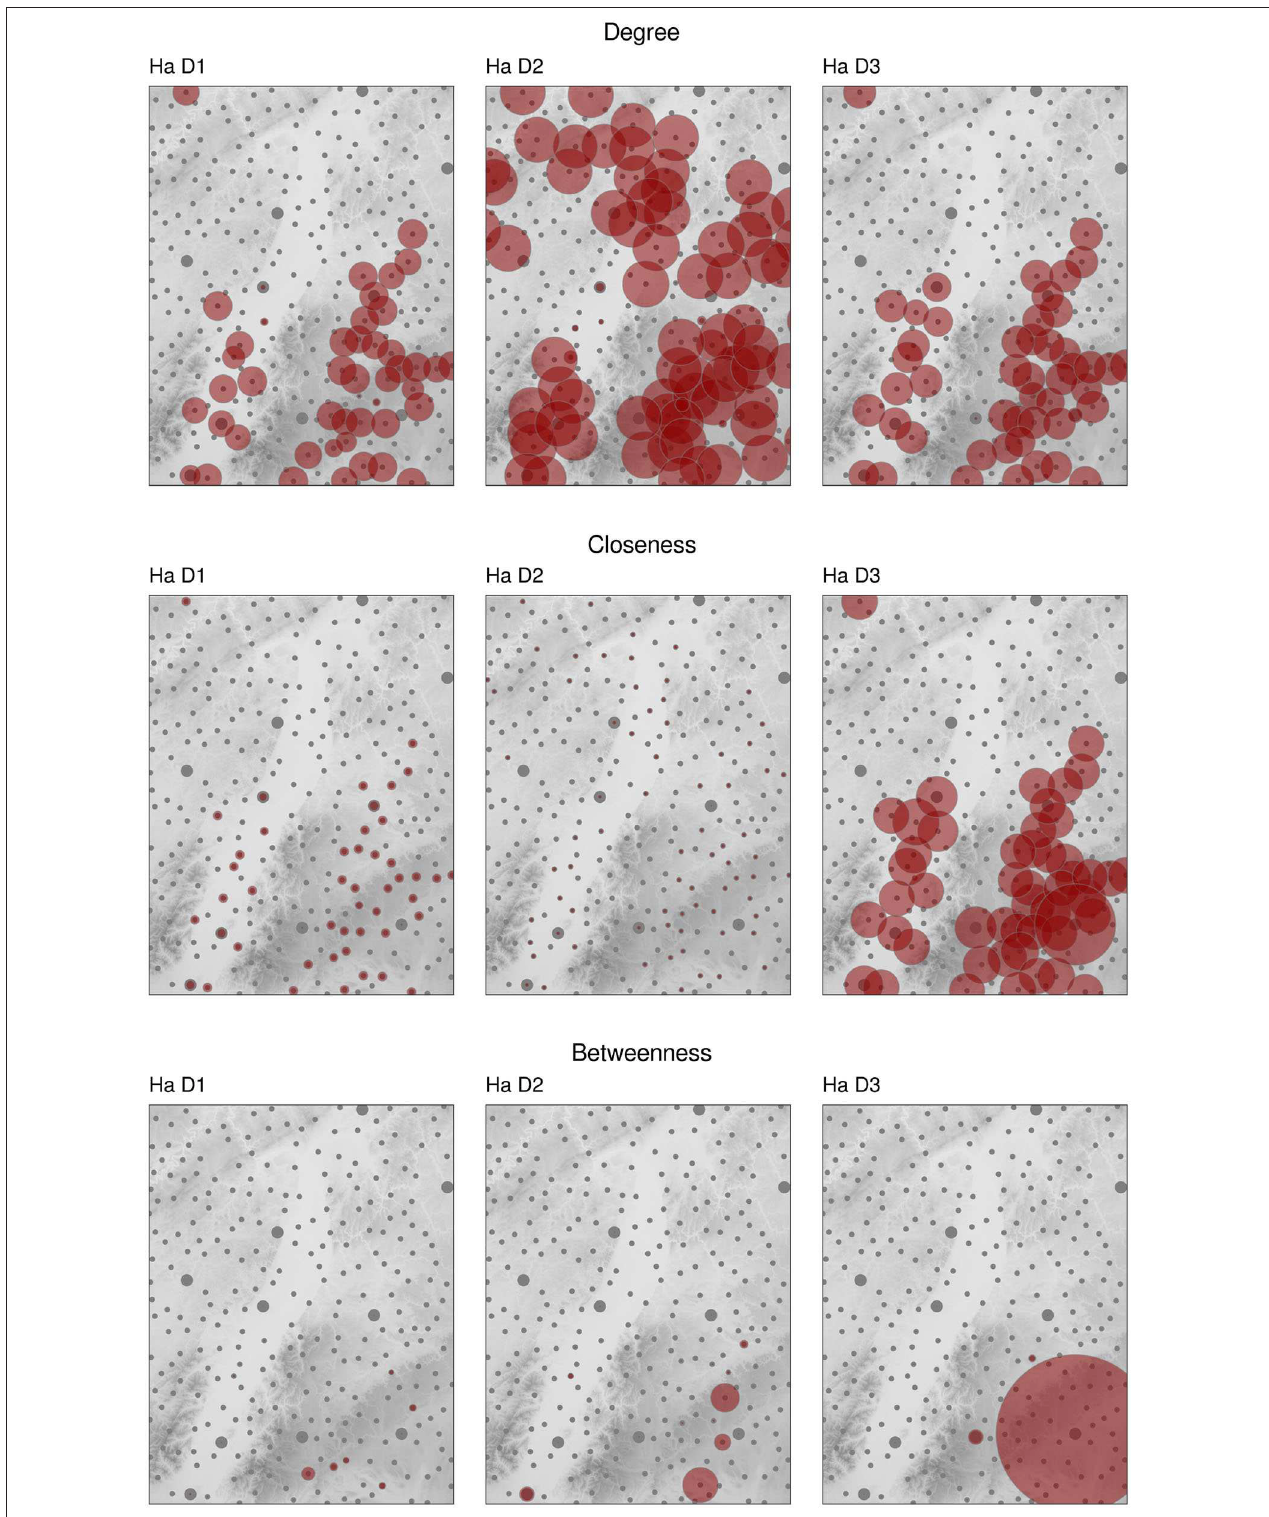
FIGURE 4 | Degree, closeness, and betweenness of cut weighted graphs. Gray points are the simulated sites and the Princely Seats, the red circles indicate the centrality according to the mentioned index, where the size of the circles corresponds with the centrality. The symbols of each row is scaled differently.